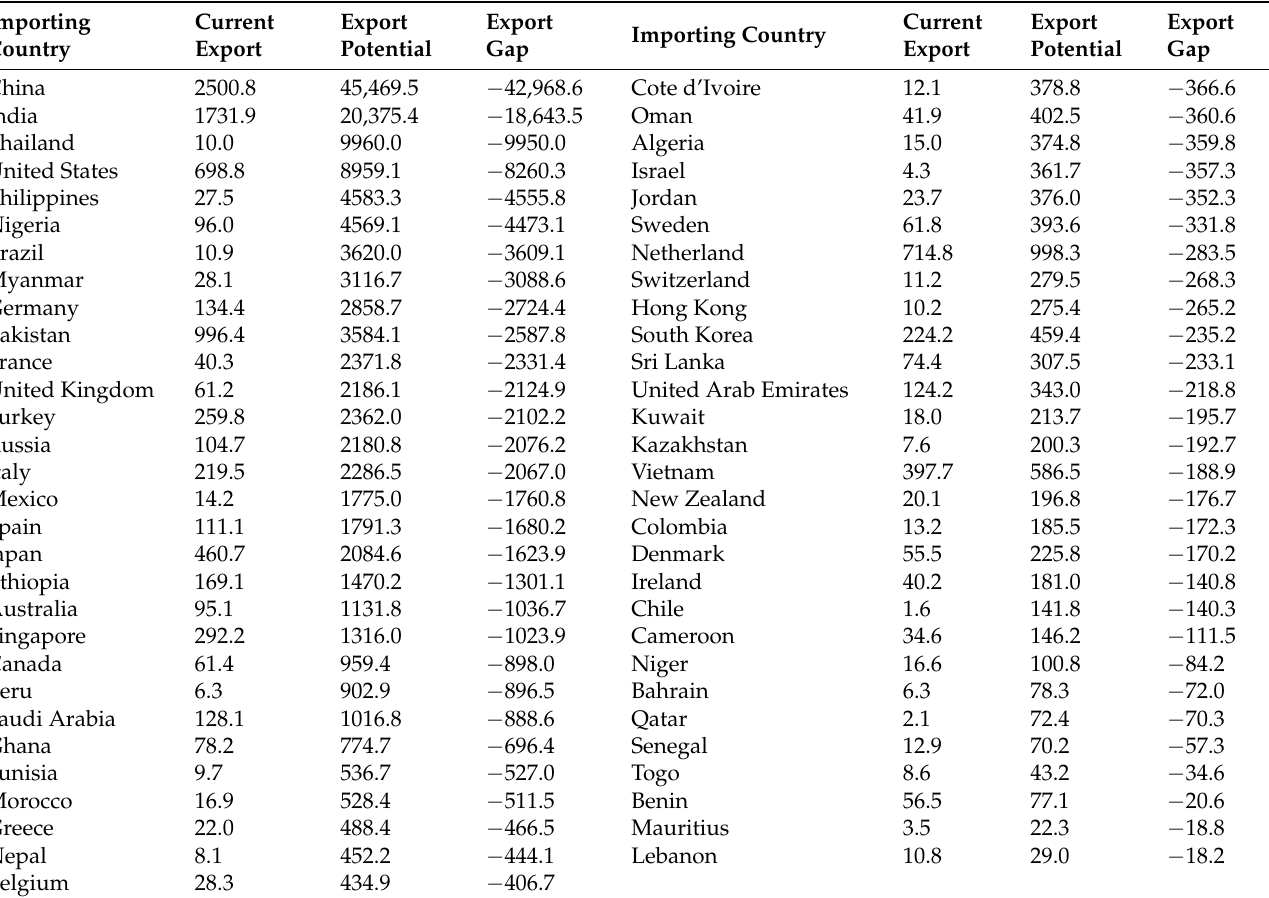
Table 6. Malaysia Palm Oil Export Potential and Export Gap, average million USD (2009–2019).